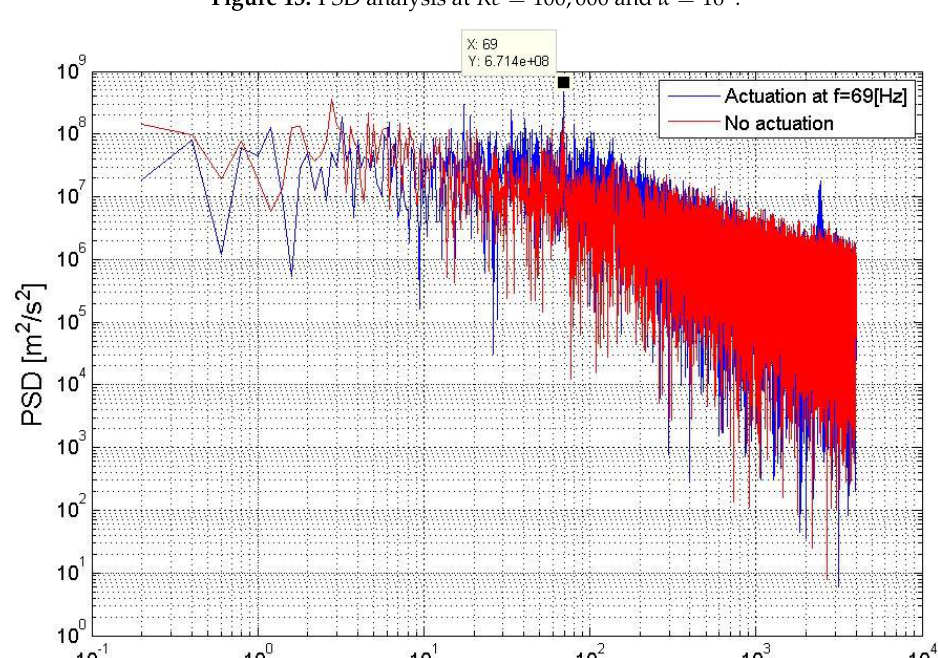
Figure 13. PSD analysis at Re = 100,000 and α = 16 ◦ .